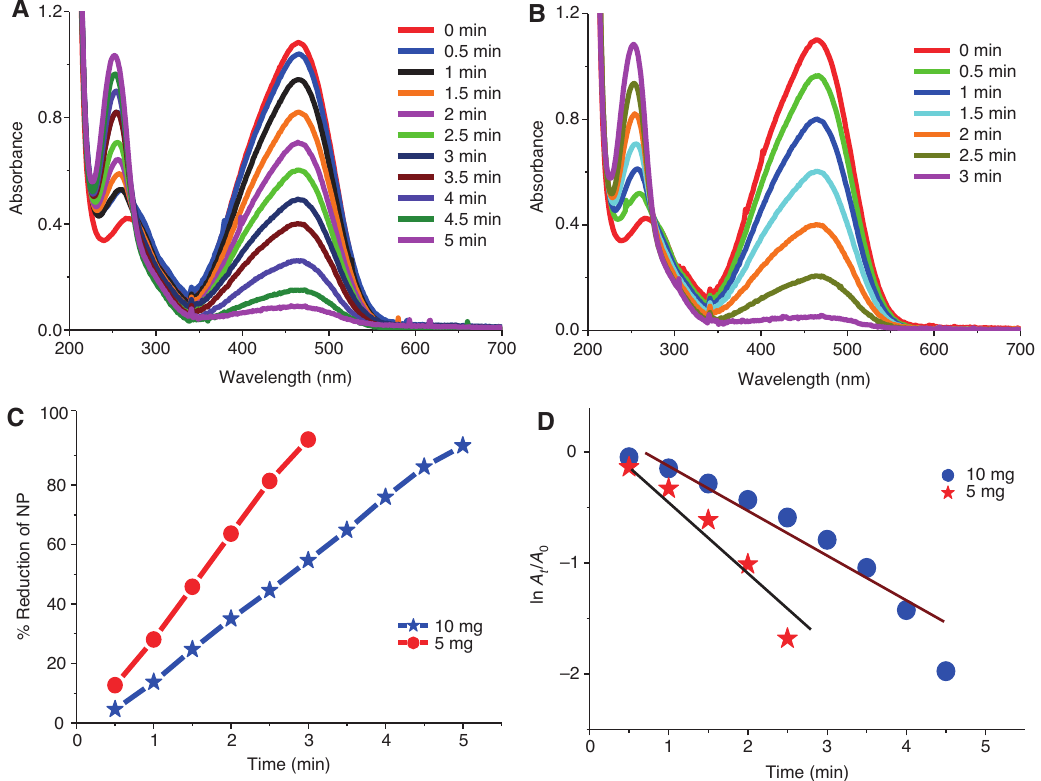
and 5 mg AgNPs and (B) 10 mg AgNPs, (C) comparative percent reduction of MO dye, 4